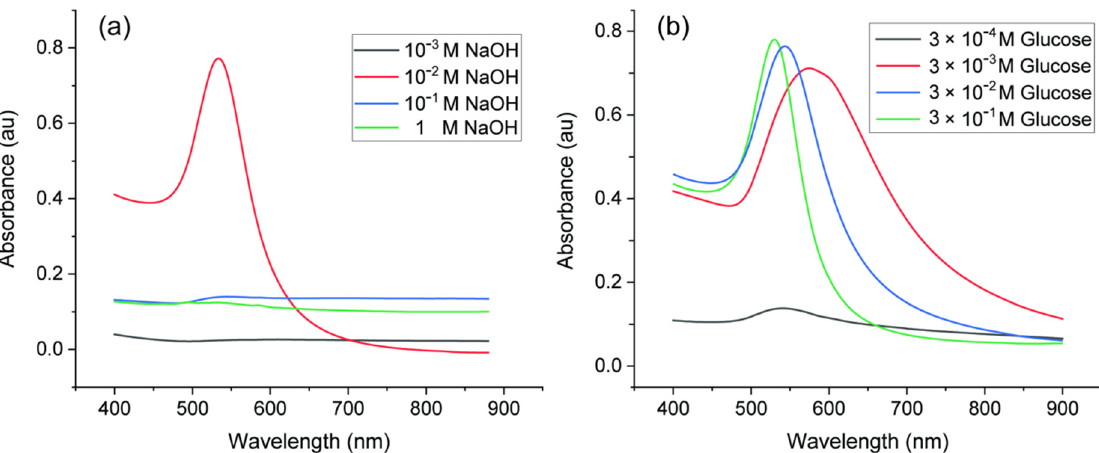
Figure 4. UV − Vis spectra of AuNPs synthesized with various reagent concentrations: ( a ) 0.1% HAuCl 4 , 3 × 10 − 2 M glucose and various concentrations of NaOH; ( b ) 0.1% HAuCl 4 , 10 − 2 M NaOH and various concentrations of glucose.